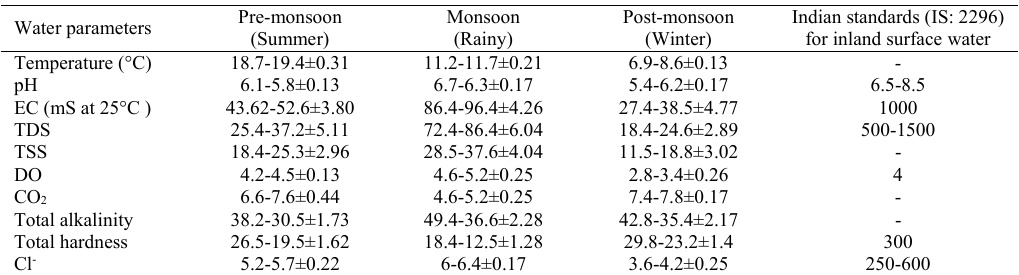
Table 1: Physicochemical characteristics and temporal variations in Khacheopalri Lake water parameters (Min-Max ± St. Dev, Water parameters